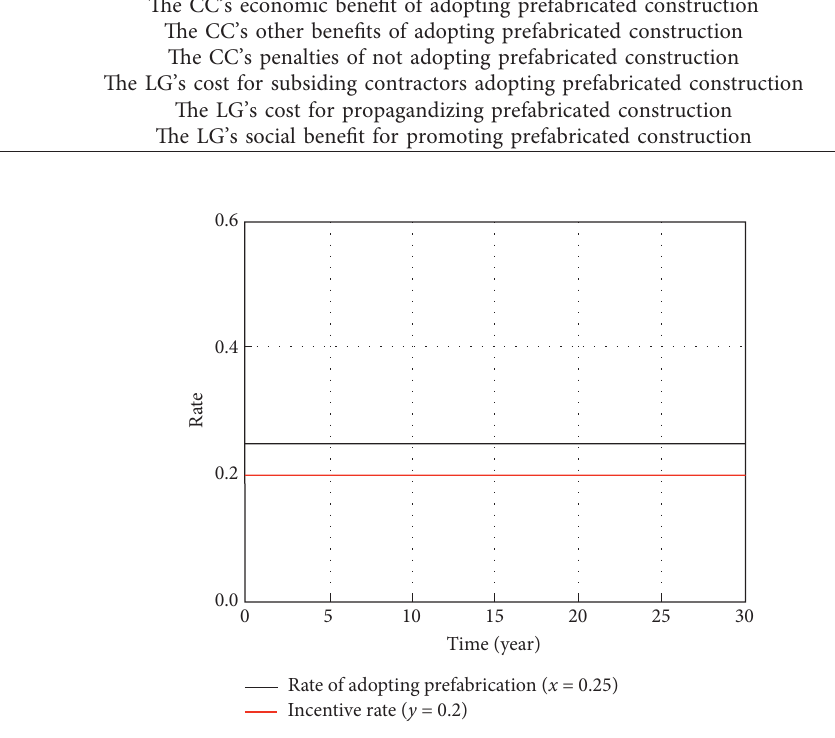
Figure 2: Simulation results under the equilibrium solution of mixed strategy (0.25,